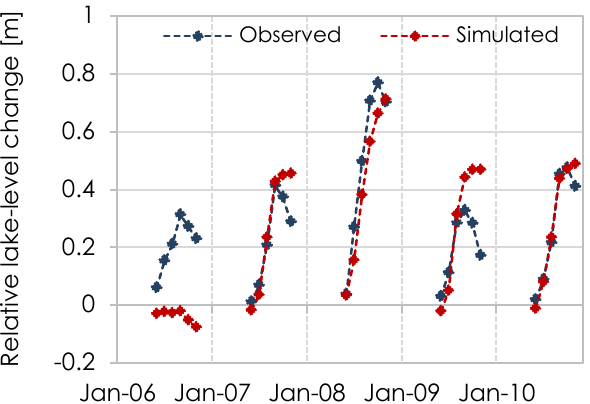
Figure 3. Monthly averaged lake-level observations from Nam Co (blue) vs. simulated lake levels (red) for the June–November period of the years 2006 through 2010.